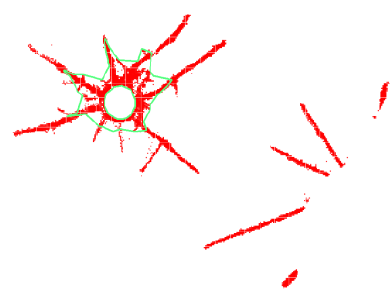
Fig 9. Cross section (9.3m) with fitting circle (green)